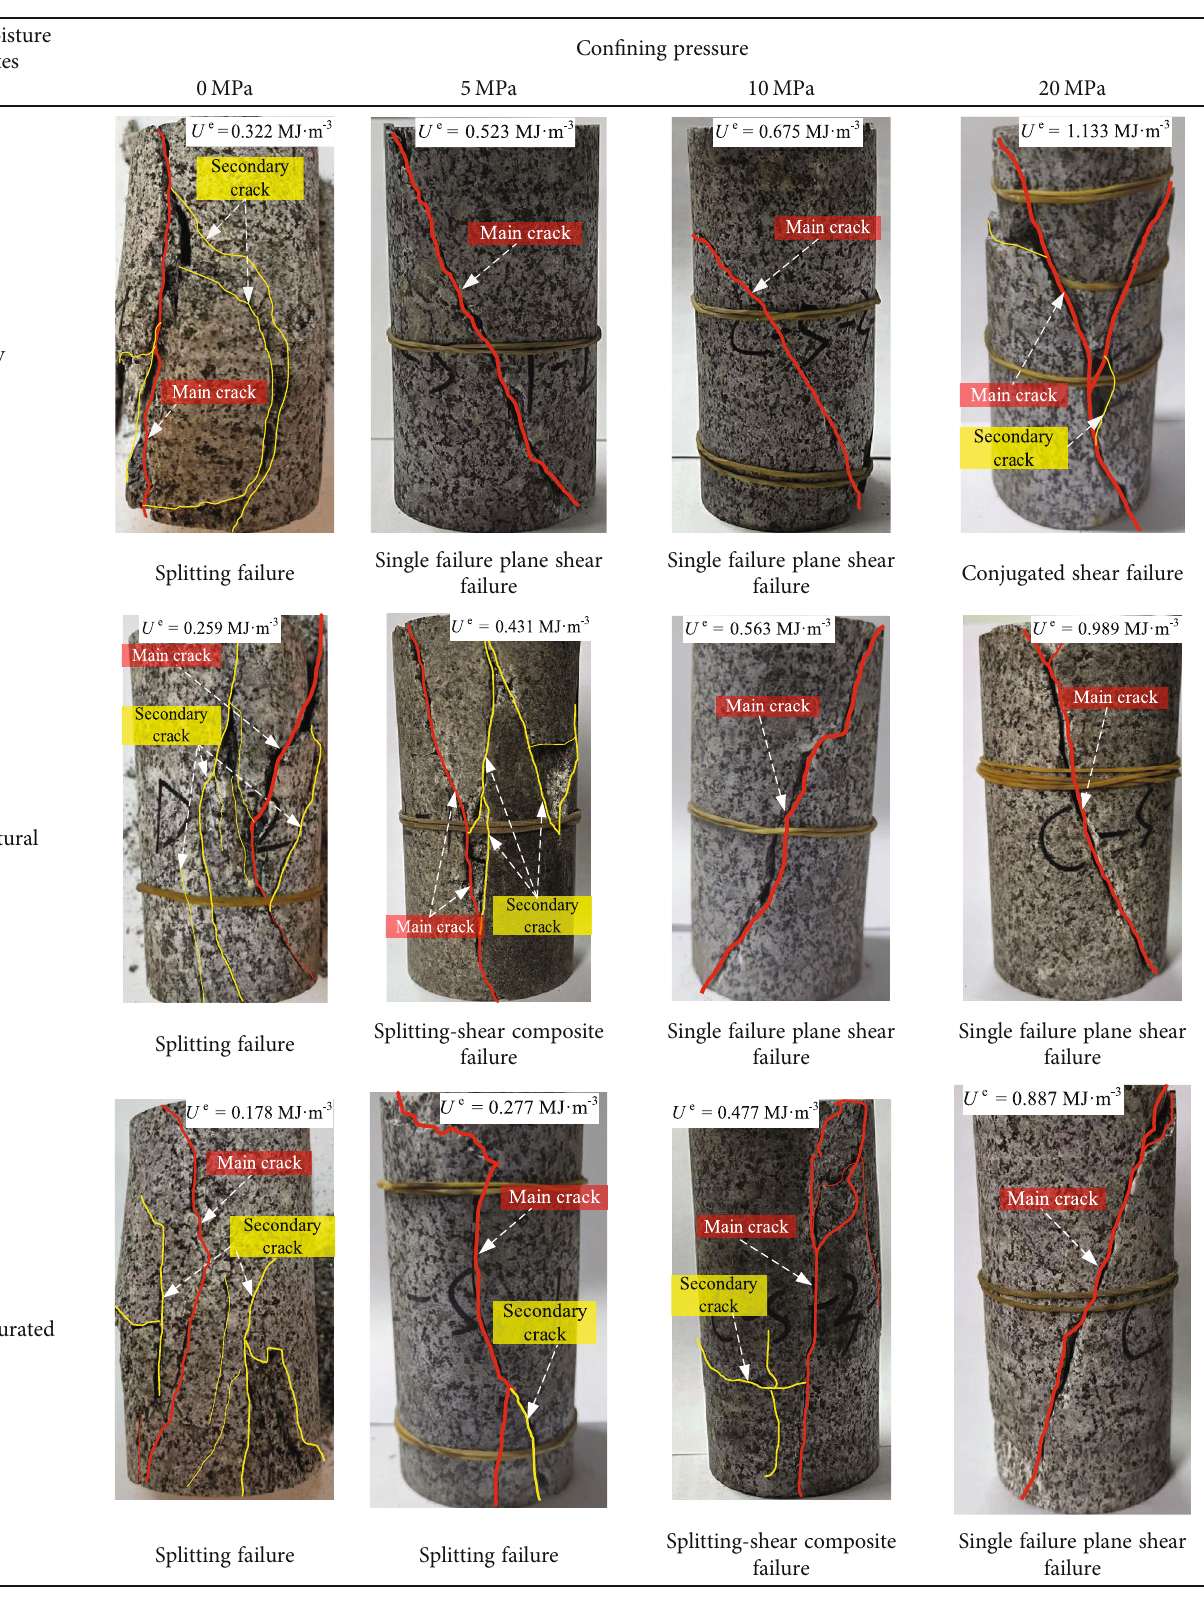
Table 1: Failure morphology of granite under di ff erent